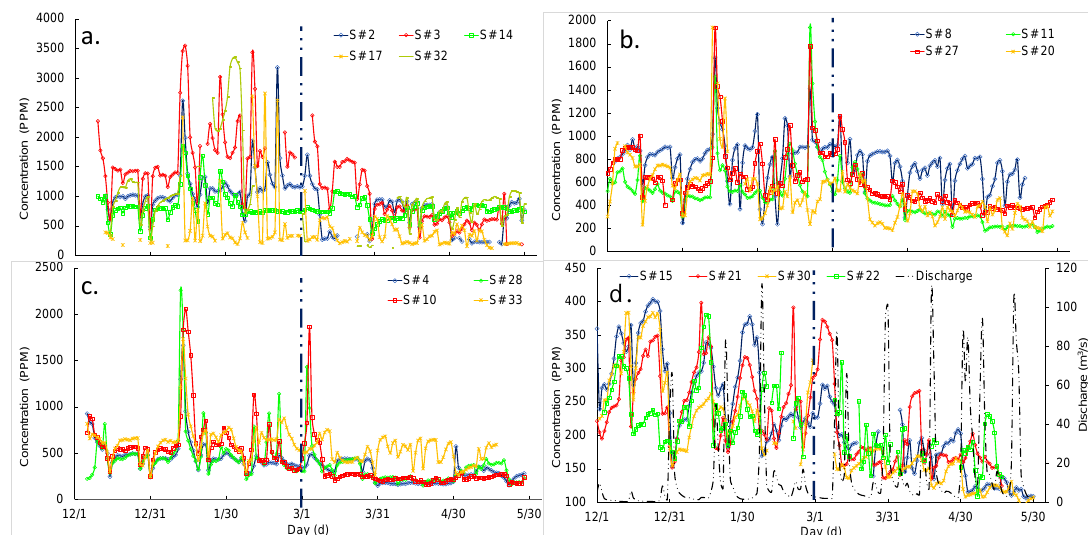
Figure 2. Time series of daily average salt concentration from 1 December 2018 to 31 May 2019, at different sites: ( a ) parking-lot drain; ( b ) roadside drain; ( c ) urban-stream and ( d ) stream. Black dashed line (secondary axis) is discharge (m 3 /s) measured at USGS 05587900 gage station in Cahokia Creek. Blue dashed vertical line separates winter (December, January, and February) and spring (March, April, and May) seasons.